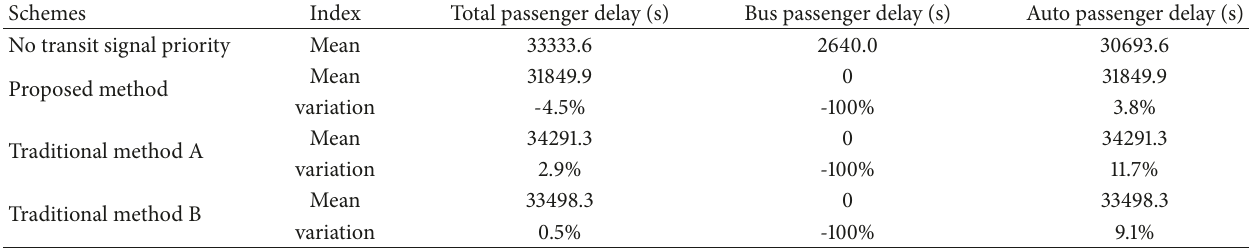
Table 5: Comparisons of three methods about delay variation.